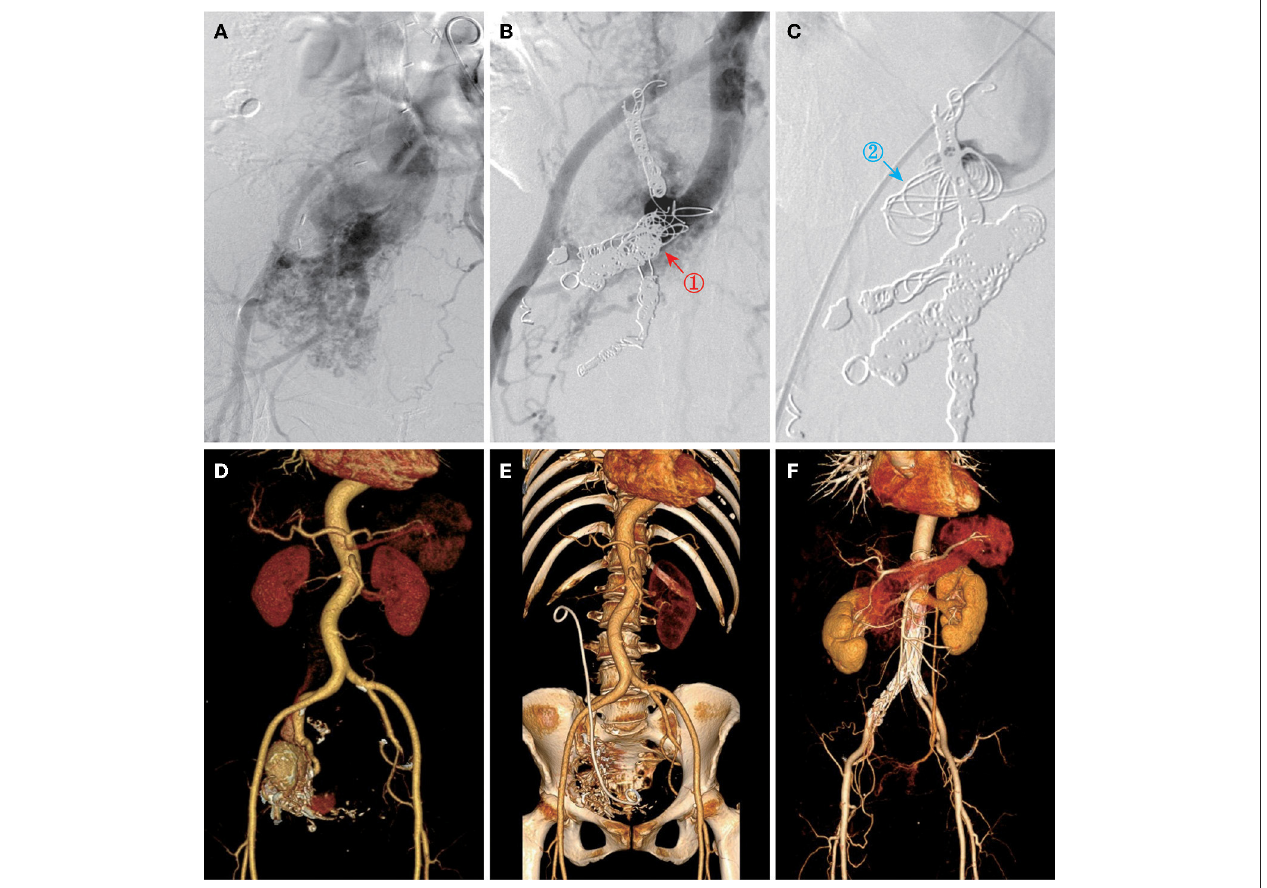
FIGURE 3 | Other three types of endovascular approach. (A) Angiography showed IAVFs in a 49-year-old female (case 9). (B) Transarterial embolization of inflow right internal iliac arteries on stage I (red arrow and “ ‹ ”). (C) Transvenous embolization of outflow right internal iliac vein on stage II (blue arrow and “ › ”). (D,E) Pre-